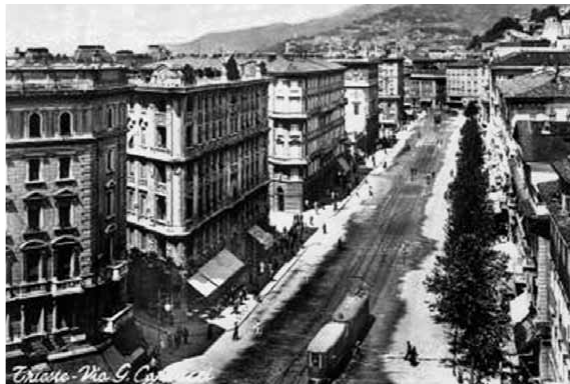
fig. 9. Via Carducci, the new Trieste’s urban axis (photo by alterocca,